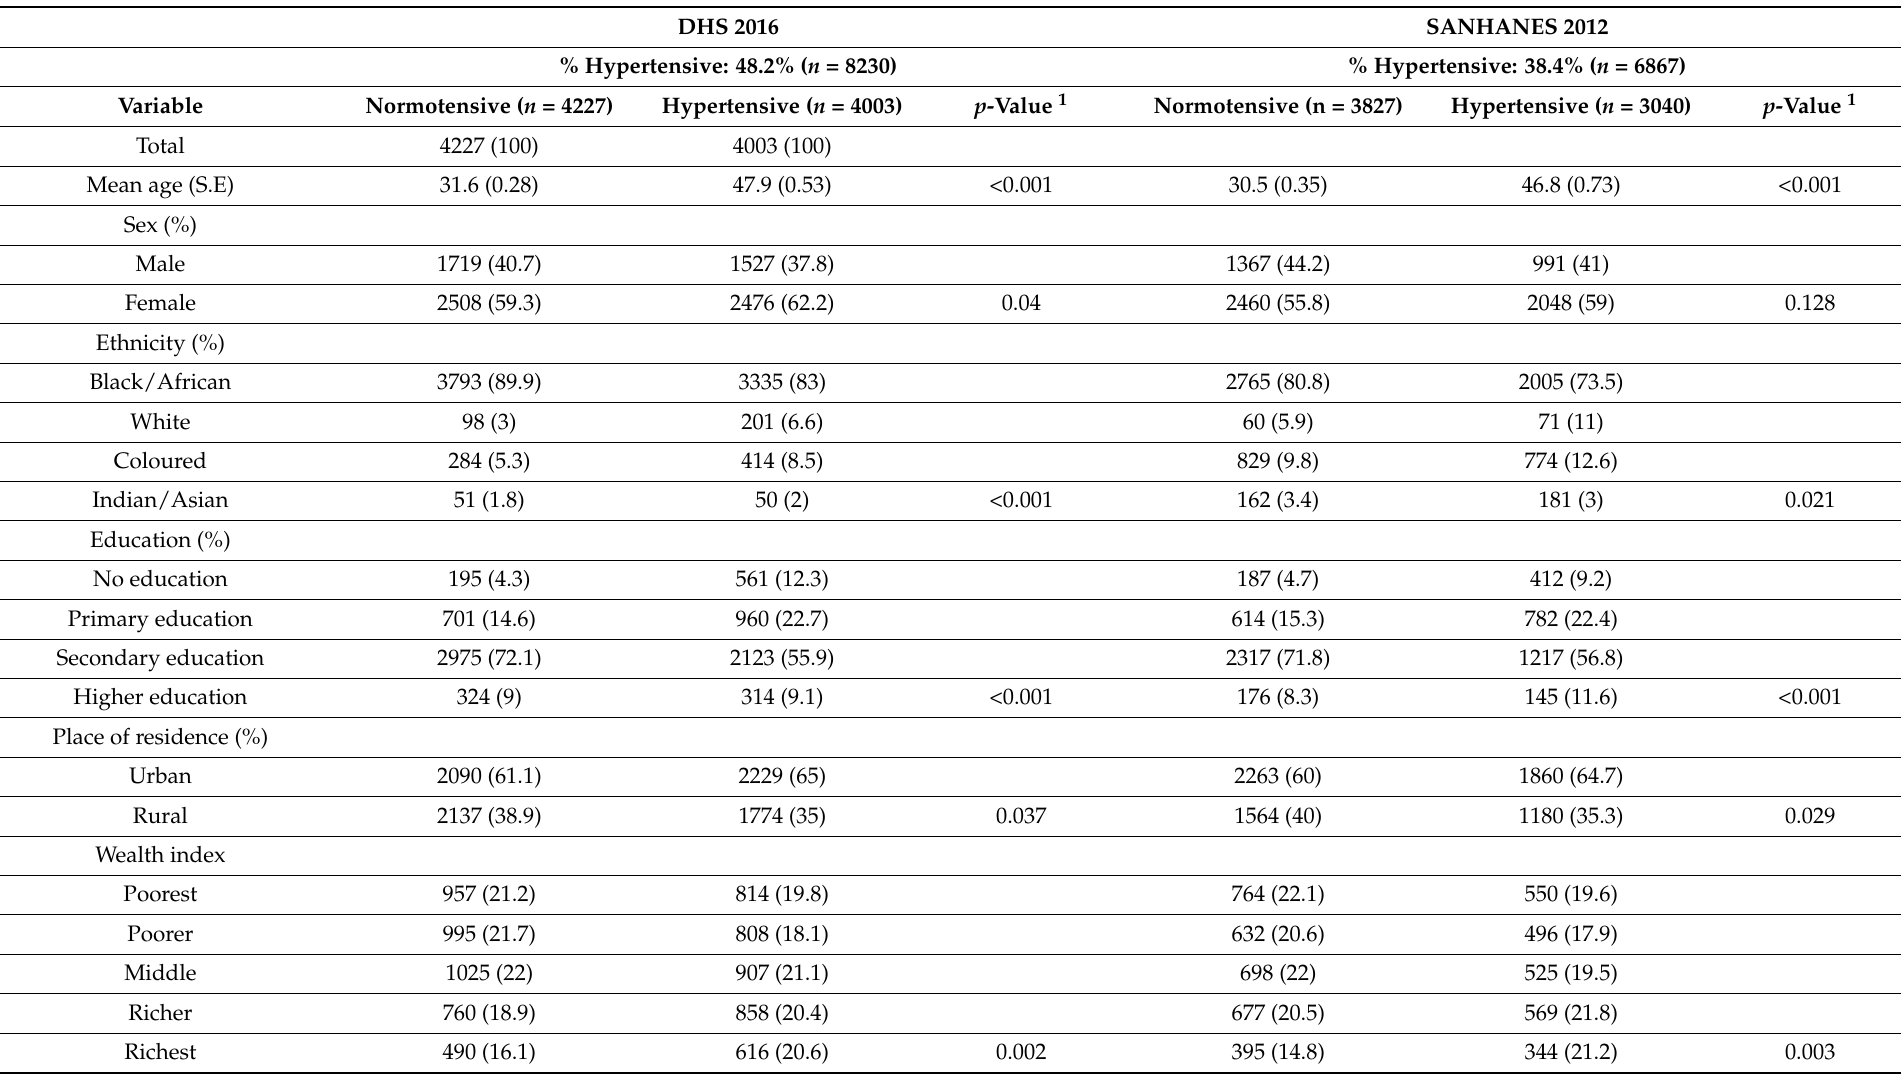
Table 1. Baseline characteristics of the study populations by hypertensive